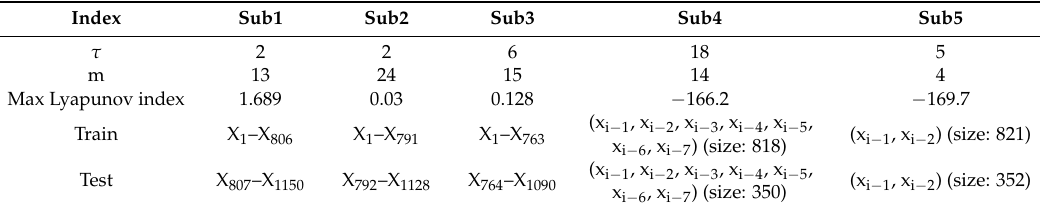
Table 4. The parameters of each subsequence after processing by